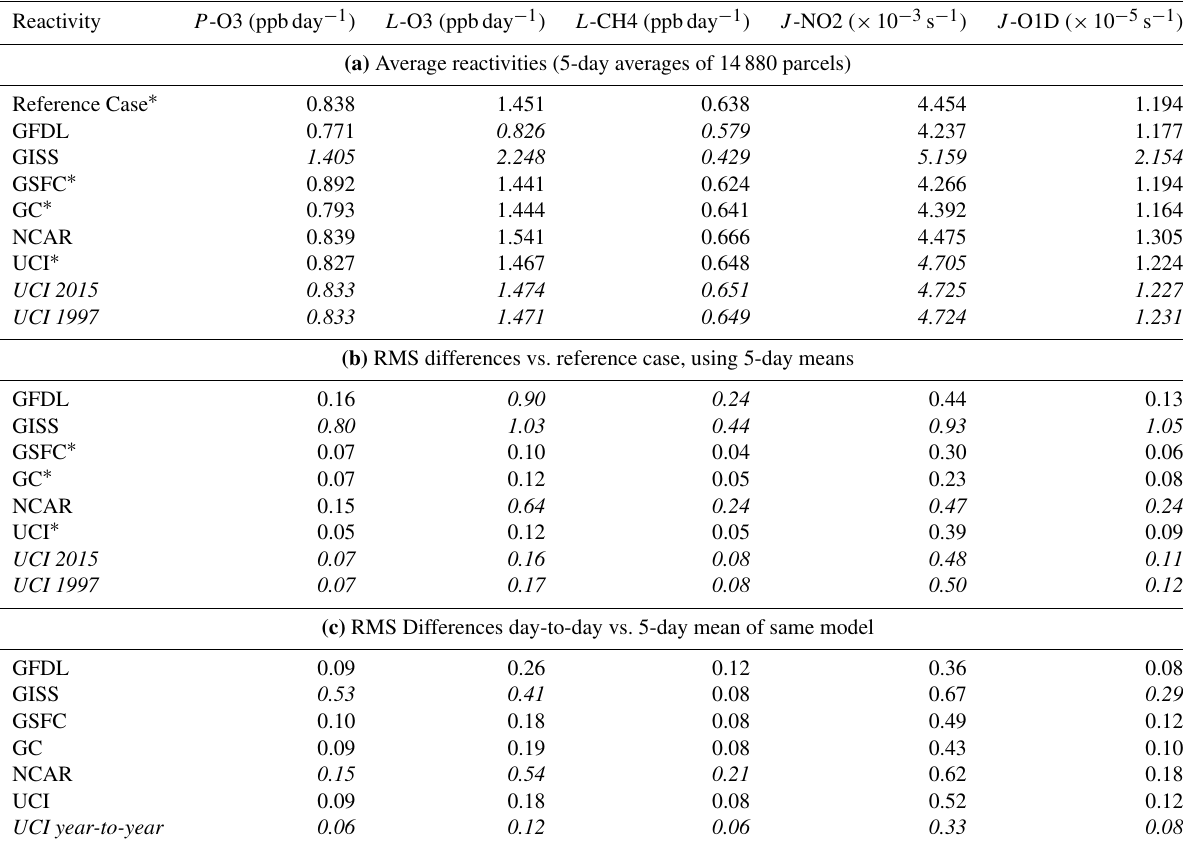
Table 3. Average reactivities and standard deviations with respect to the reference case (average of three models).